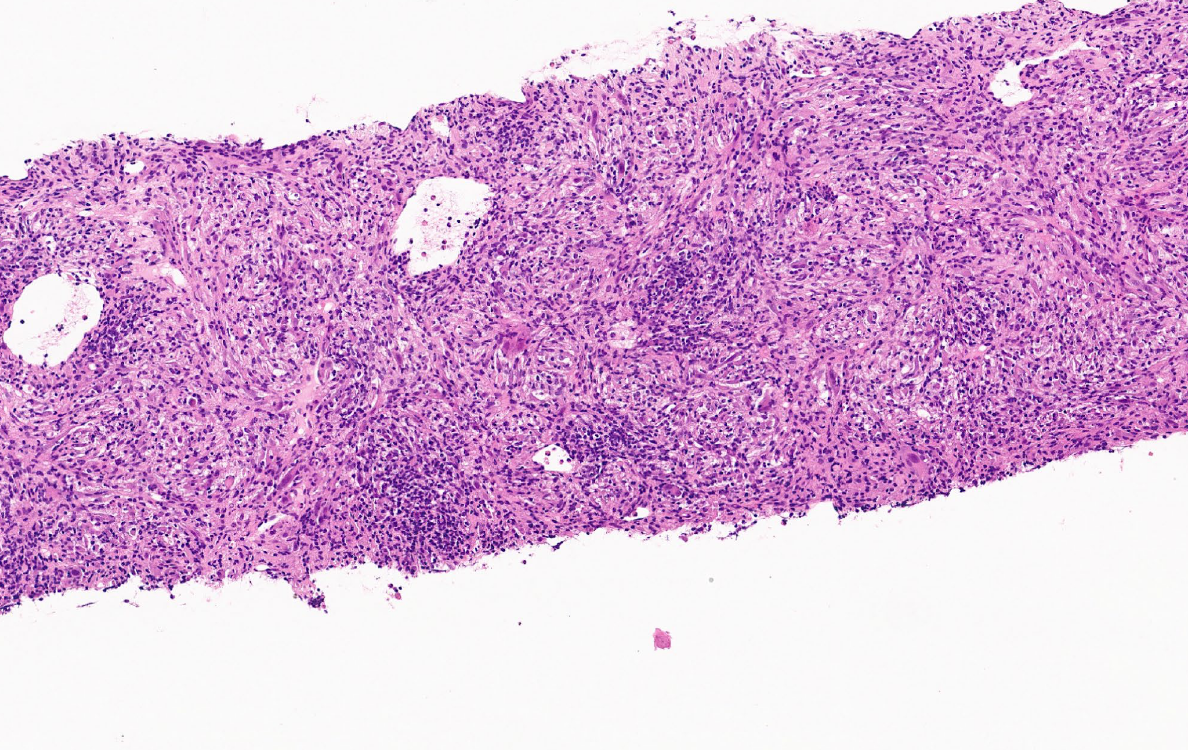
Fig. 2 Core needle biopsy (CNB). A mesenchymal spindled cell proliferation confirming crossed bundles associated with a lymphoplasmacytic infiltrate